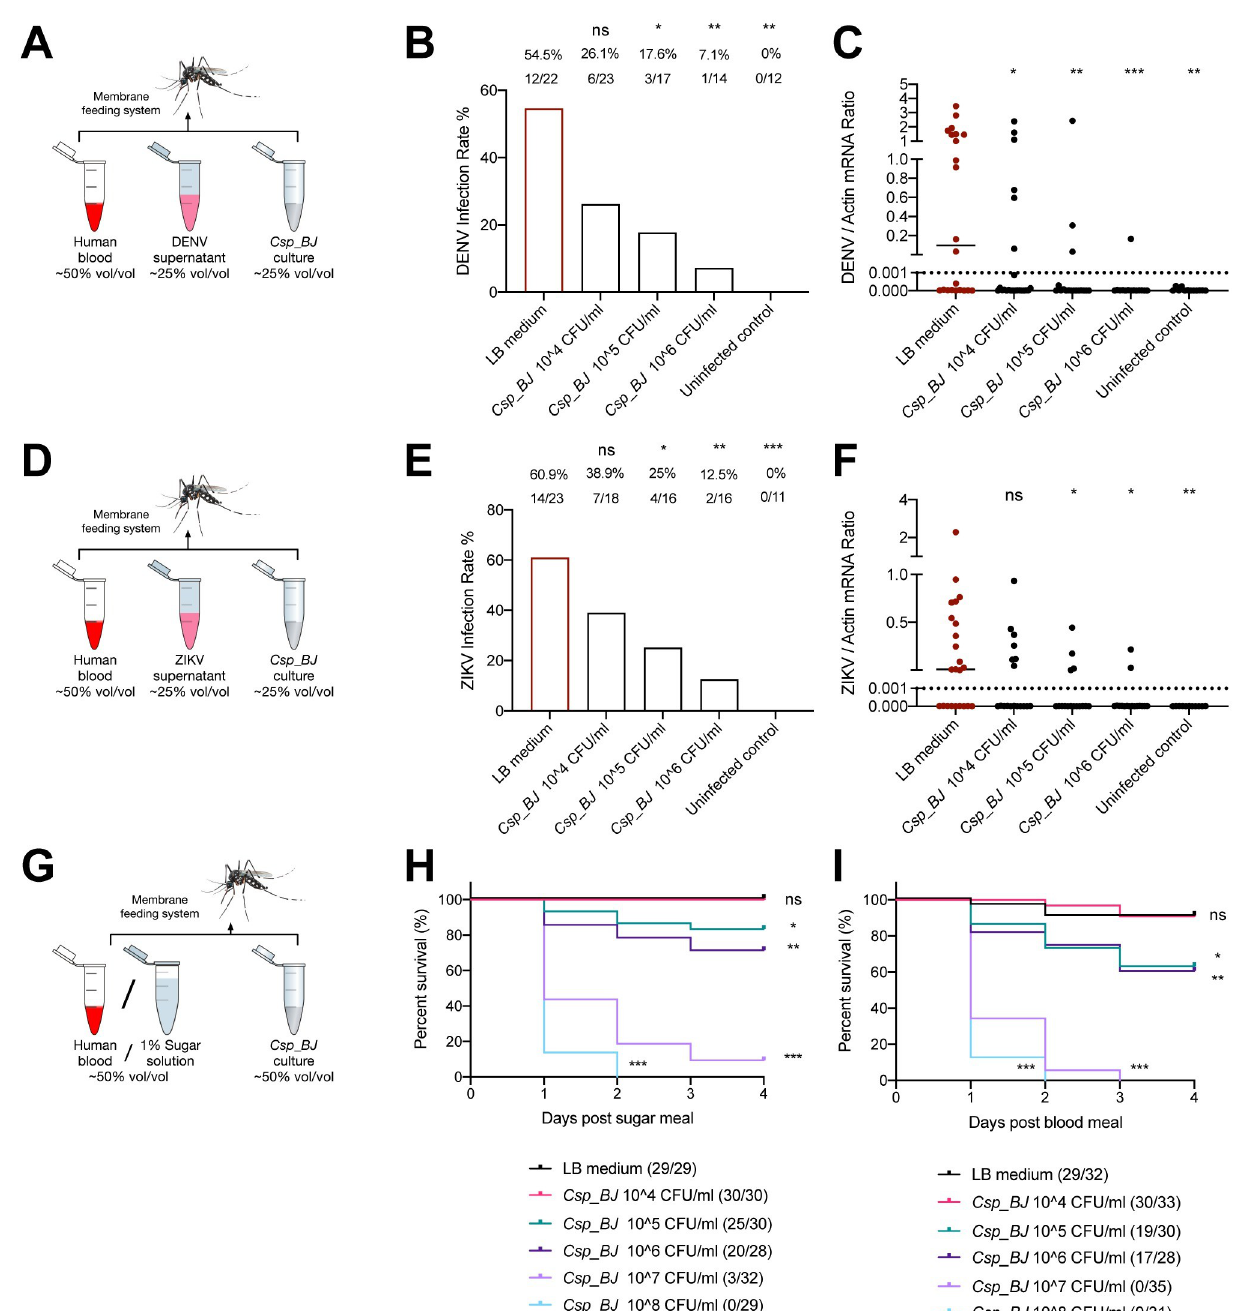
Fig 1. Csp_BJ shows virucidal activity against DENV and ZIKV as well as entomopathogenic activity in A . aegypti . (A-F) Oral supplementation with Csp_BJ inhibits DENV (A-C) and ZIKV (D-F) infection of A . aegypti . (A, D) Schematic representation of the study design. A mixture containing human blood (50% v/v), Csp_BJ bacterial suspension (25% v/v), and supernatant from DENV- (A) or ZIKV- (D) infected Vero cells (25% v/v) was used to feed antibiotic-treated A . aegypti Rockefeller strain via a membrane blood feeding system. Mixtures containing human blood (50% v/v), fresh LB broth (25% v/v), and supernatant from DENV- or ZIKV-infected Vero cells (25% v/v) served as negative controls. A mixture containing human blood (50% v/v), Csp_BJ bacterial suspension (25% v/v), and fresh VP-SFM medium (25% v/v) served as an uninfected control. Mosquito infectivity was determined by RT–qPCR at 8 days post blood meal. The final DENV or ZIKV titre was 1 × 10 5 PFU/mL for oral infection. (B, E) Mosquito infection rate after oral supplementation of Csp_BJ culture with DENV (B) or ZIKV (E). (C, F) Mosquito viral load after oral supplementation of Csp_BJ culture with DENV (C) or ZIKV (F). (G-I) Oral supplementation with Csp_BJ caused a high mortality rate in A . aegypti . (G) Schematic representation of the study design. A mixture containing 1% sugar solution (H) or human blood (I) (50% v/v) and Csp_BJ bacterial suspension (50% v/v) was used to feed antibiotic-treated A . aegypti via a membrane blood feeding system. Mixtures containing 1% sugar solution or human blood (50% v/v) and fresh LB broth (50% v/v) served as